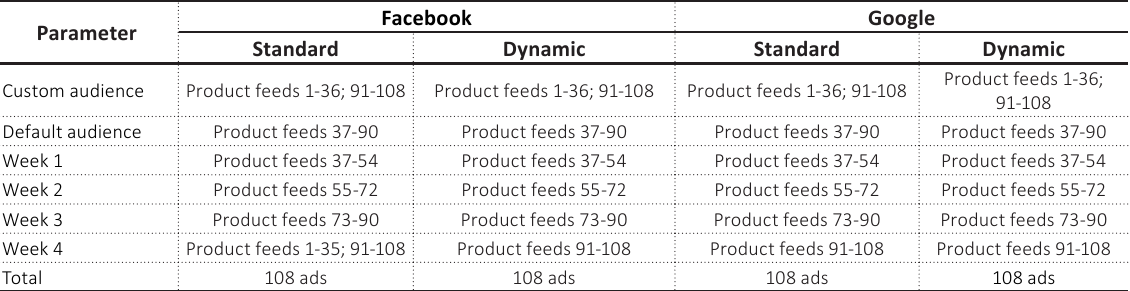
Table 1. Parameters and numbers of the test campaigns